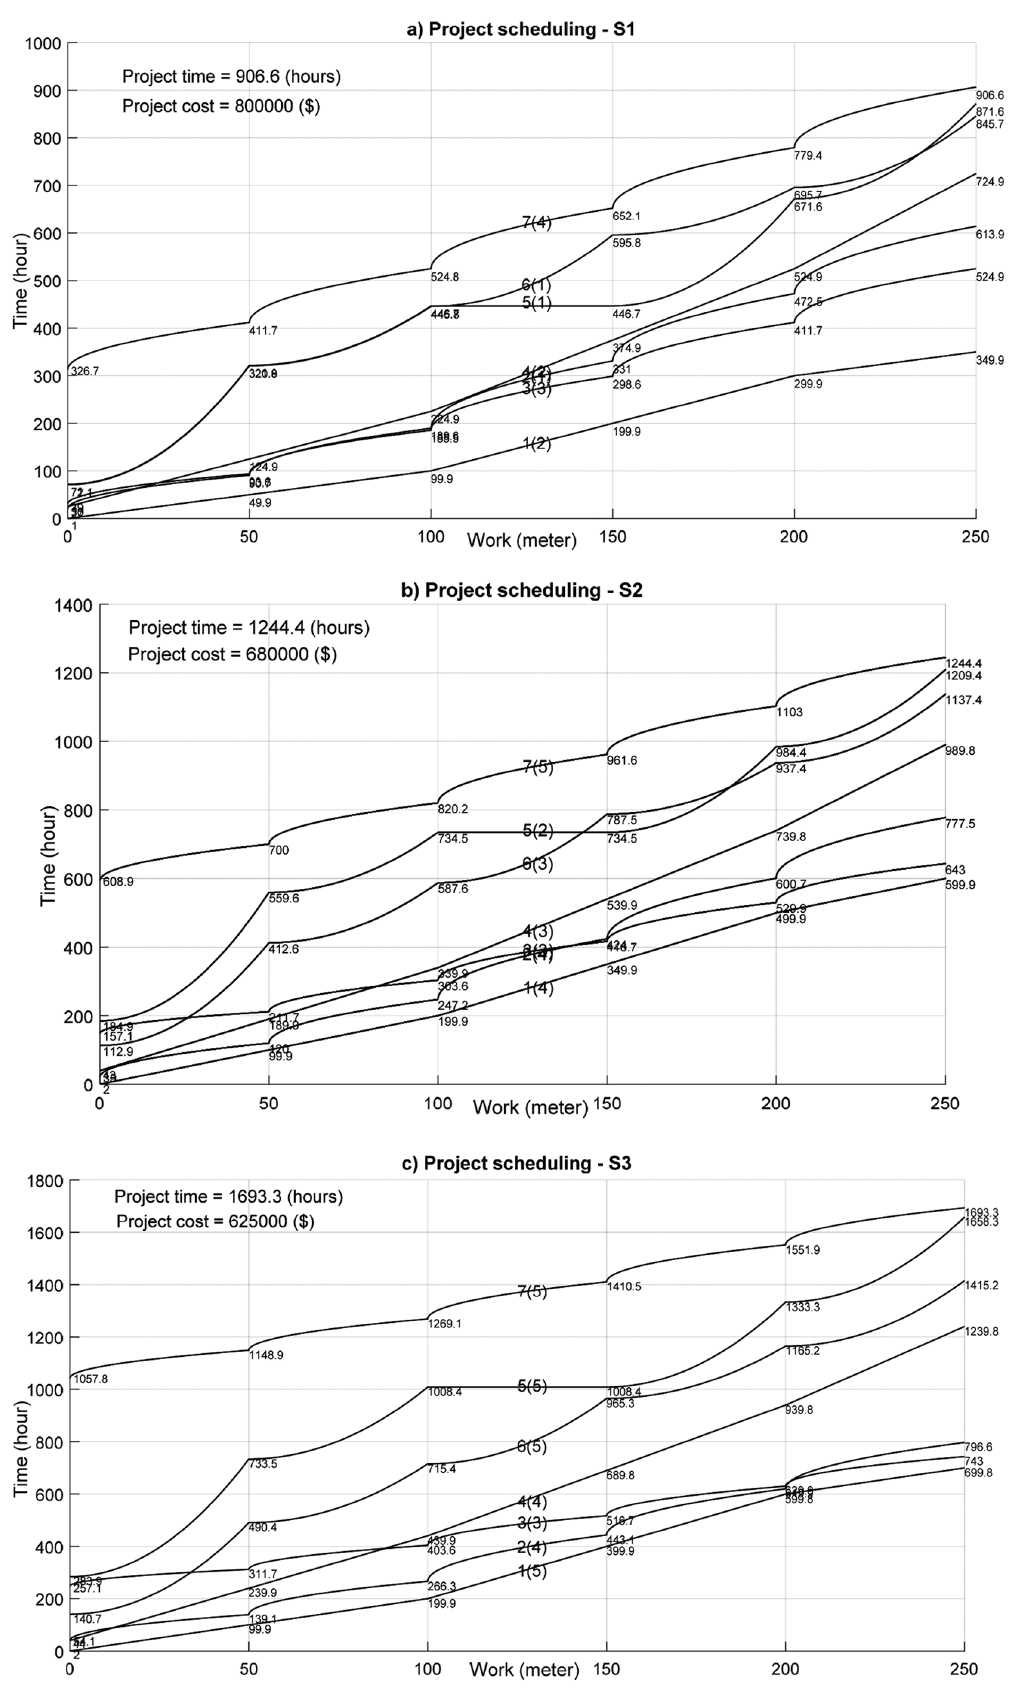
Figure 8. Schedules associated with three non-dominated solutions for case